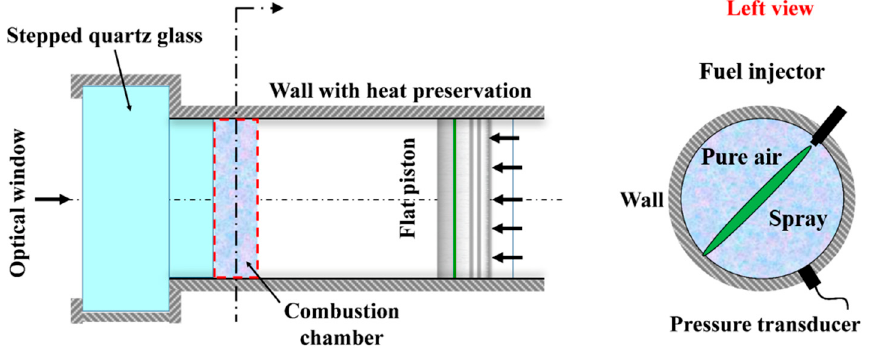
Figure 2. Schematic of optical combustion chamber and fuel injector and pressure transducer layout.